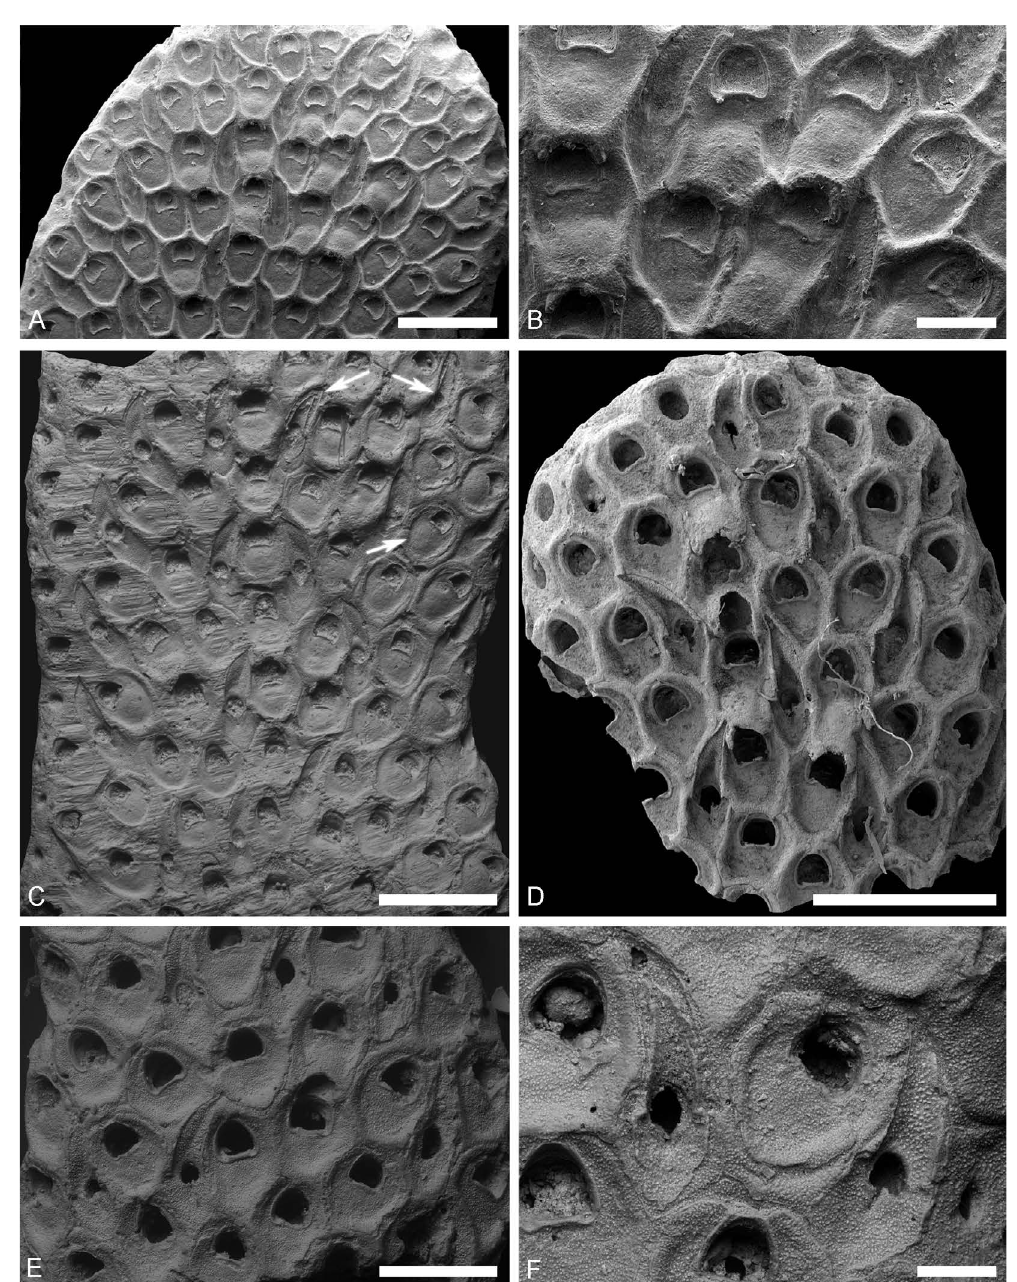
Fig. 4. Rhagasostoma inelegans (Lonsdale, 1850). A–C . Early Campanian, Alemannia quarry, Sehnde- Höver, Lower Saxony, Germany. A–B . SMF 24564. A . Distal part of erect bifoliate colony. B . Autozooids and avicularia (ooecia of endozooidal ovicells are clearly visible). C . SMF 29915, fragment of erect bifoliate colony with rare ovicellate autozooids, intramural non-ovicellate autozooid within autozooid and intramural avicularia within avicularia (arrowed). D–F . Erratic block of Campanian age, quarry near Hrodna/Grodno (Гродна/Гродно), Grodno Region, Belarus. D . PIN 2922/219, overview of erect bifoliate colony with row of three ovicellate autozooids, one with a broken ooecium, and avicularia. E–F . PIN 2922/273. E . Autozooid with broken ooecium, avicularia and non-ovicellate autozooids. F . Intramural non-ovicellate autozooid within autozooid and intramural avicularium within avicularium, and normal avicularium. Scale bars: A, C–D = 1 mm; B = 300 µm; E = 500 µm; F = 200